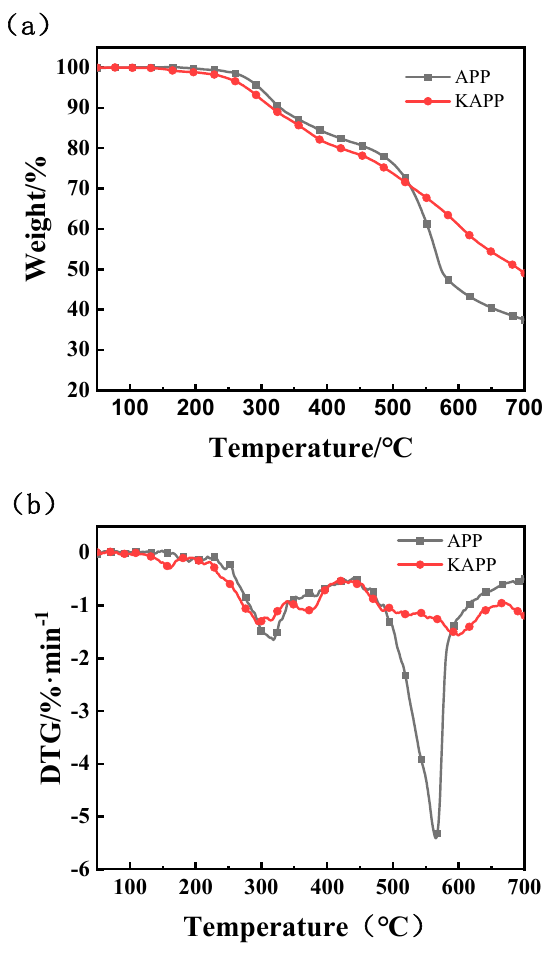
Figure 3. ( a ) TG and ( b ) DTG curves for APP and